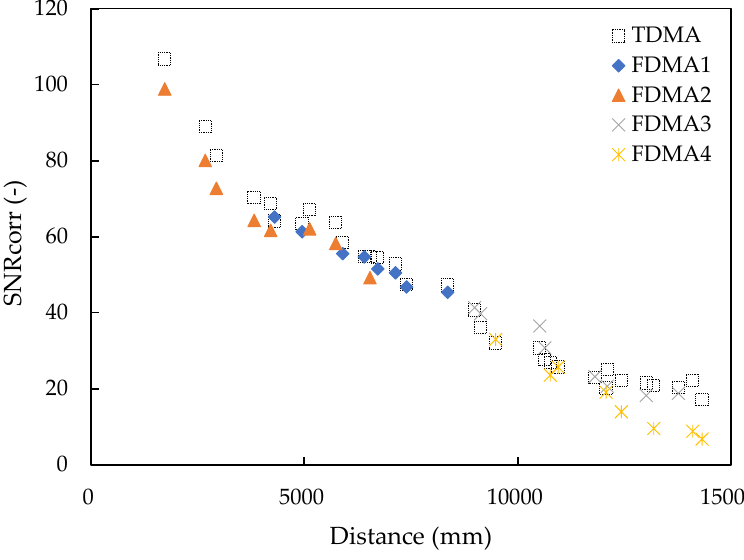
Figure 15. Signal strength decrease with distance.